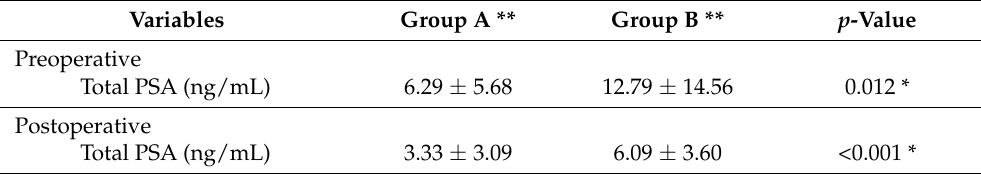
Table 2. Biochemical Values.